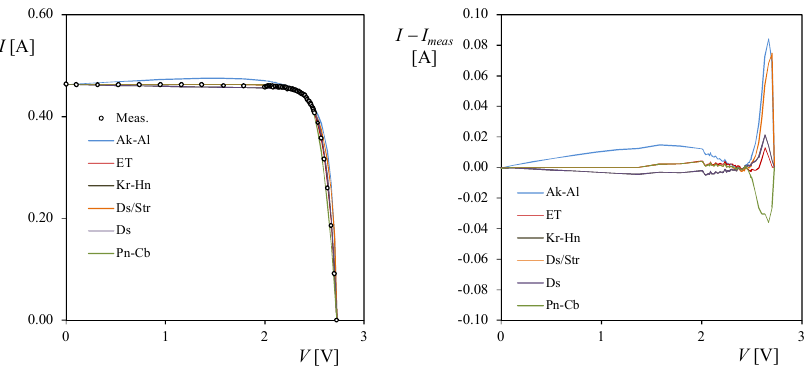
Figure 5. Curves for the explicit models analyzed, fitted to the TNJ Spectrolab solar cell data using the analytical methods proposed; see Section 2 ( left ). The error in relation to the data is also included in the figure ( right ). Energies 2018 , 11 , x FOR PEER REVIEW